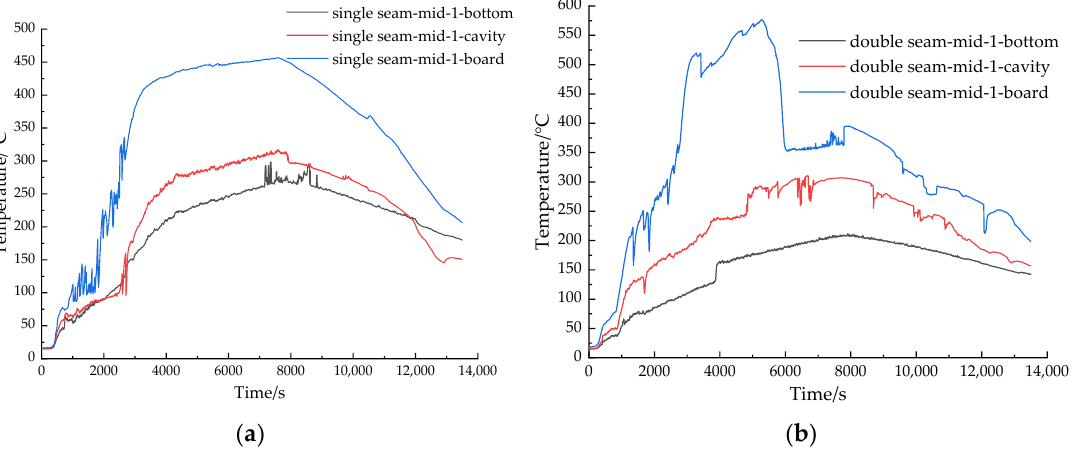
Figure 16. Time-temperature curves of the measuring points in the cavity. ( a ) Condition of the single seam; ( b ) condition of the double seam.